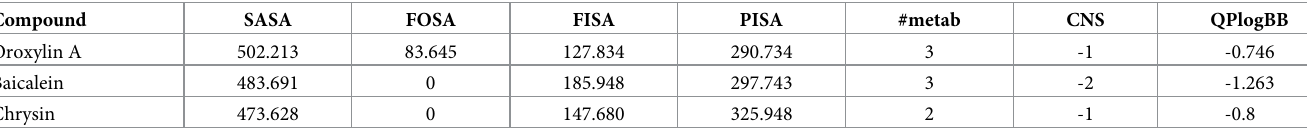
Based on the existing literature, the current study is the first to illustrate the novel neuroprotec- tive effects of OIE against CICI in in vivo and in-silico analysis showing favorable ADME of Oroxylin A, Baicalein and Chrysin. The neuroprotective studies of OIE were established using several valid behavioral and biochemical studies. For the behavioral studies, open field test, Y- maze, NOR, MWM were used to validate the cognitive protective effects of OIE. The open field test is an accepted qualitative and quantitative scientific behavioral measure of explor- atory performance and general activity in rodents [17]. Intriguingly, it measures several facets